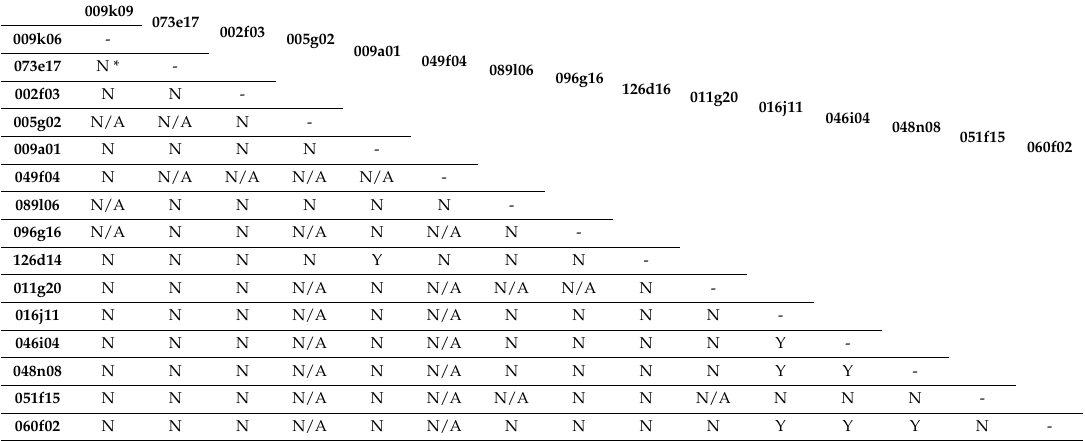
Y—pairs of BAC clones hybridized to the same chromosome pair; N—pairs of BAC clones hybridized to different chromosome pairs; N/A, not analyzed.